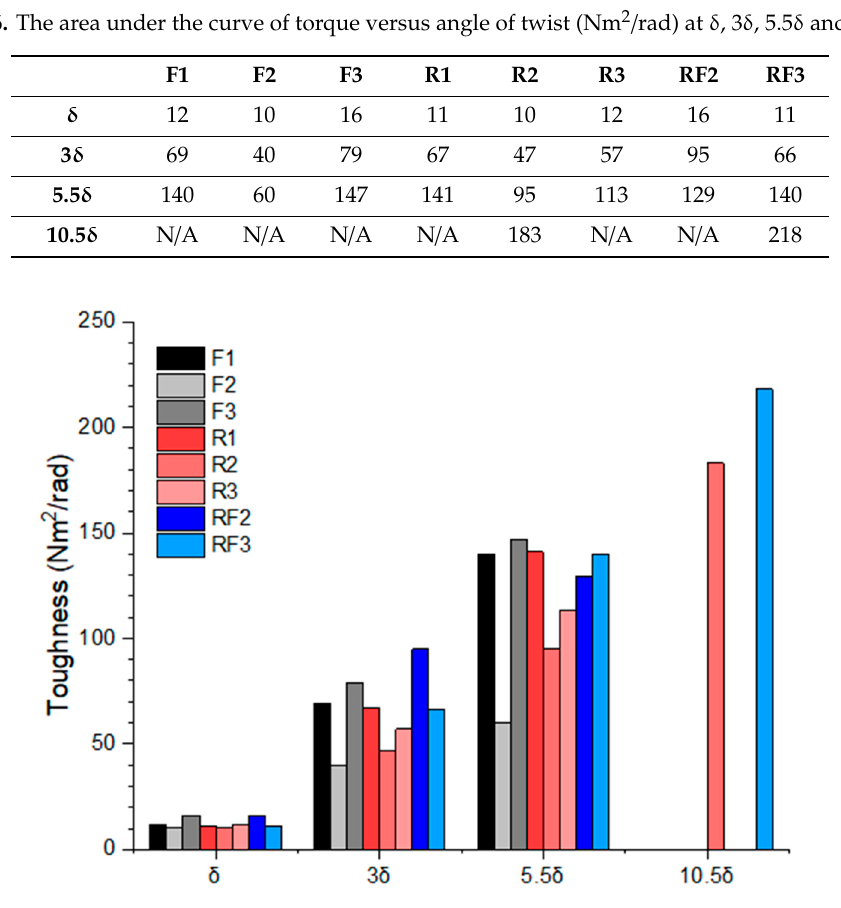
Figure 9. The plot of the area under the curve of torque versus angle of twist at δ , 3 δ , 5.5 δ and 10.5 δ . Table 7. Average toughness indices and residual strength factors of the beams in Table 6. The area under the curve of torque versus angle of twist (Nm 2 /rad) at δ , 3 δ , 5.5 δ and 10.5 δ .